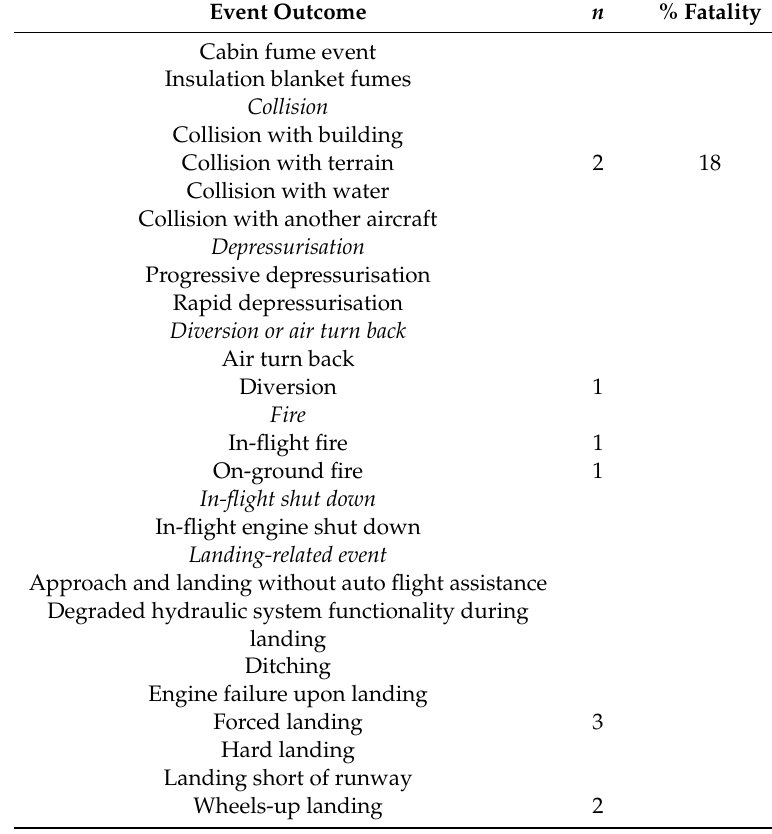
Table 6. Level 1 (Event